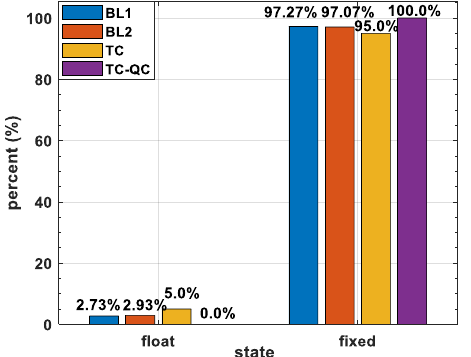
Figure 7. Success rates of ambiguity resolution.